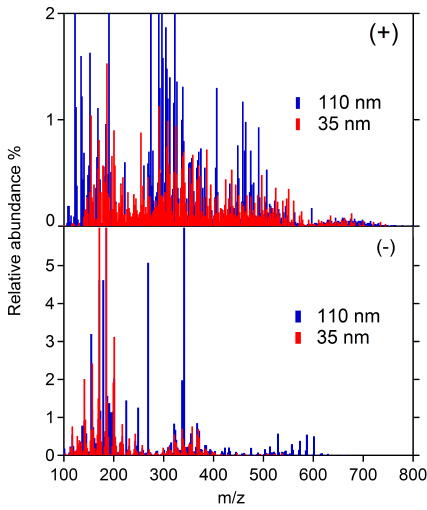
Figure 4. Carbon oxidation state (OSc) vs. number of carbon atoms for assigned molecular formulas from the positive ( + ) and nega- tive ( − ) ion mass spectra of 35 and 110 nm monodisperse SOA samples. Unique formulas in the 35nm samples are shown in red. Unique formulas in the 110nm samples are shown in blue. Formu- las common to both samples are shown in black.